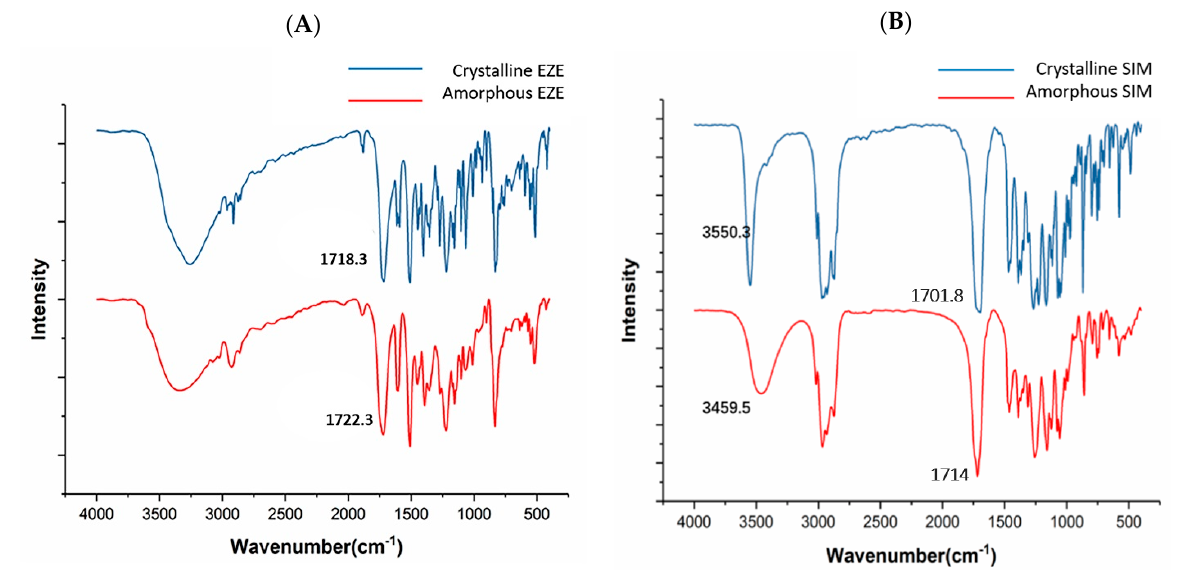
Figure 3. FT − IR spectra of pure crystalline/amorphous EZE and SIM. ( A ) Crystalline EZE and amor- phous EZE. ( B ) Crystalline SIM and amorphous SIM.